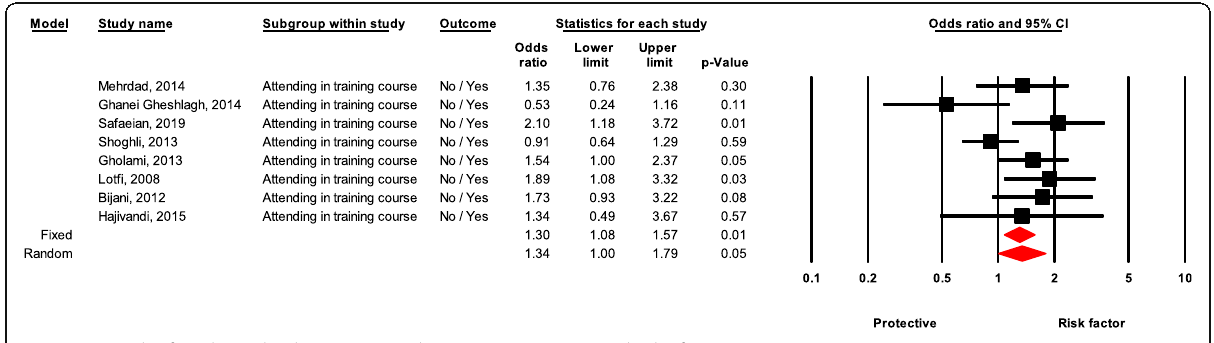
Fig. 9 Forest plot for relationship between attending in training course and risk of NSI in